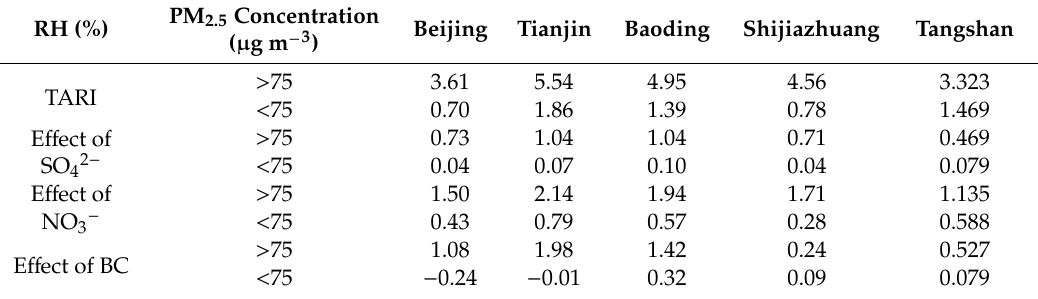
Figure 12. Simulated results of ARI effects under different particulate matter components on RH2. Table 7. The effect of ARI on RH under different PM 2.5 pollution levels.